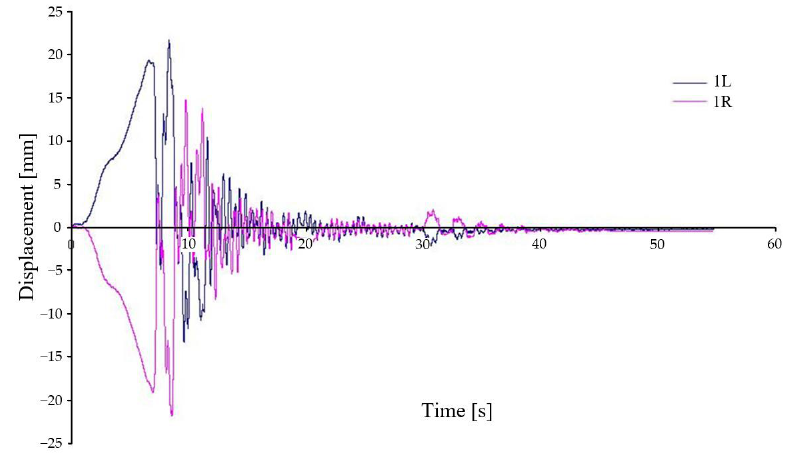
Figure 12. Relative displacement between chassis frame and wheelset—variant A–IV.